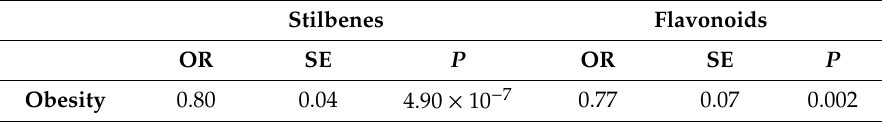
Table 2. Obesity–(poly)phenol intake (stilbenes and flavonoids) association. Stilbenes Flavonoids OR OR